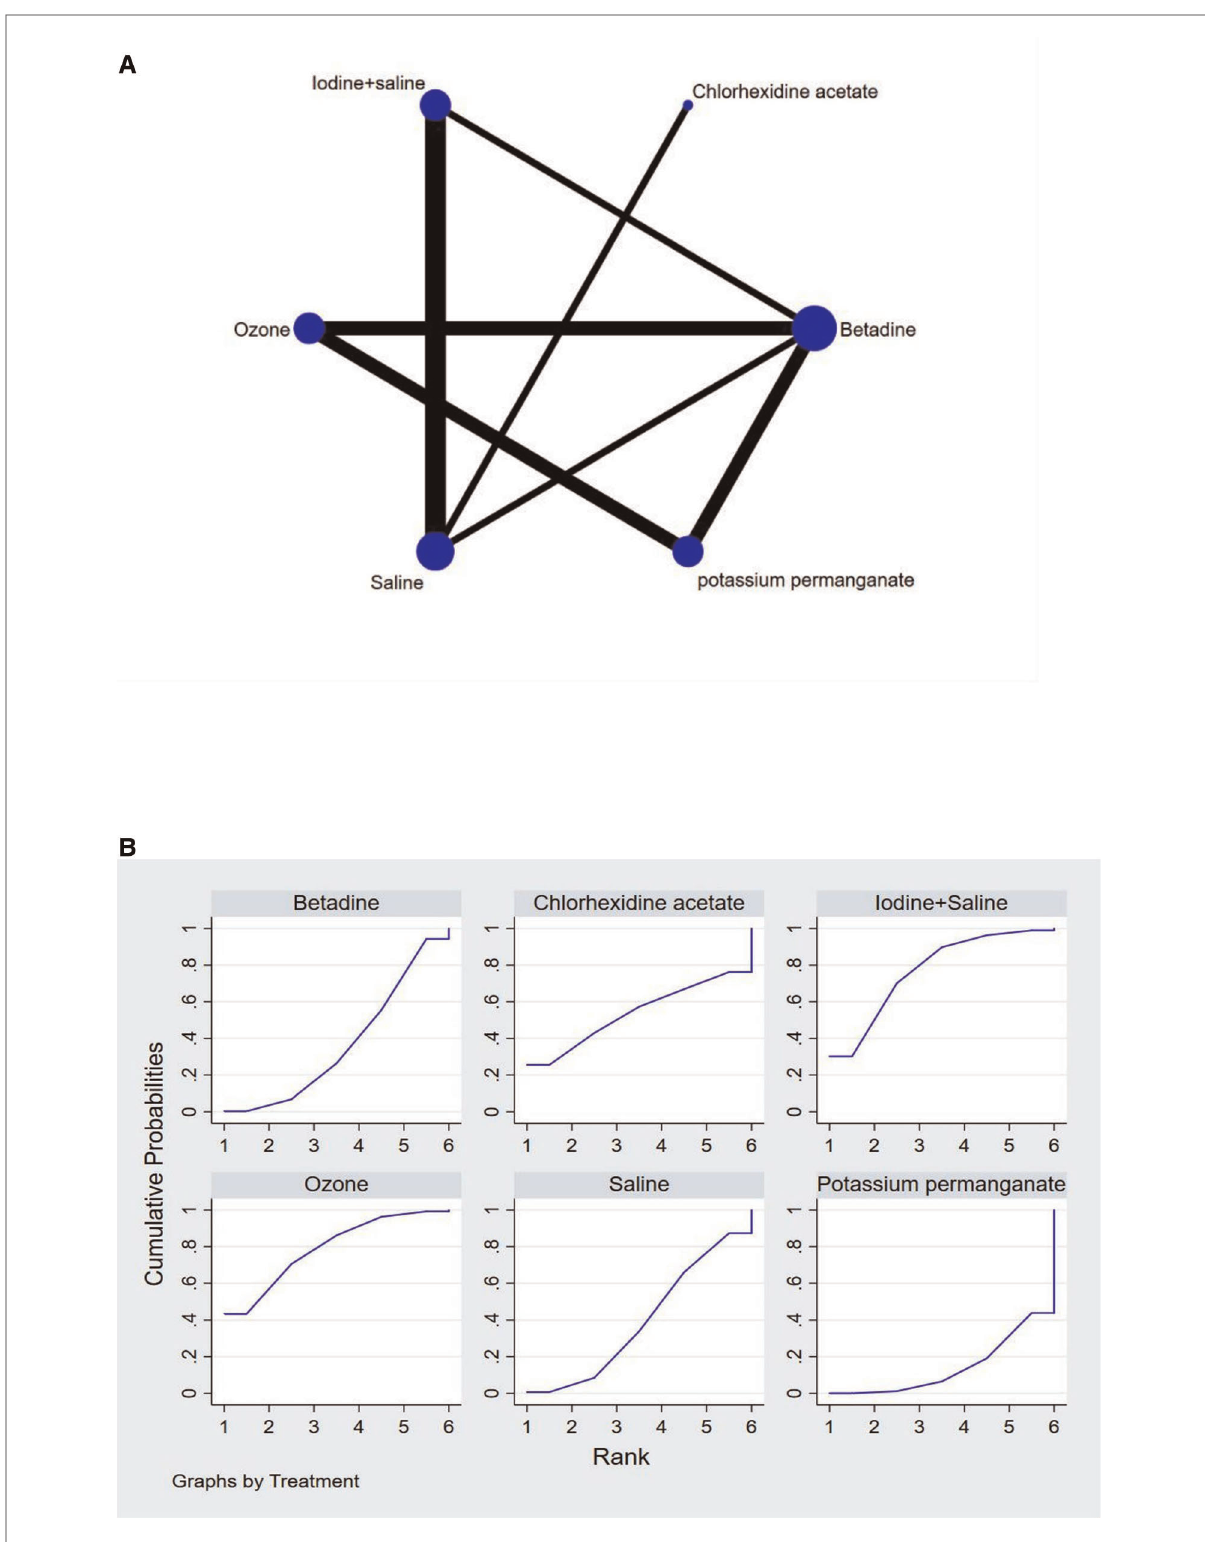
FIGURE 6 ( A ) NMA fi gure for OPU-PI ( B ) SUCRA plot for